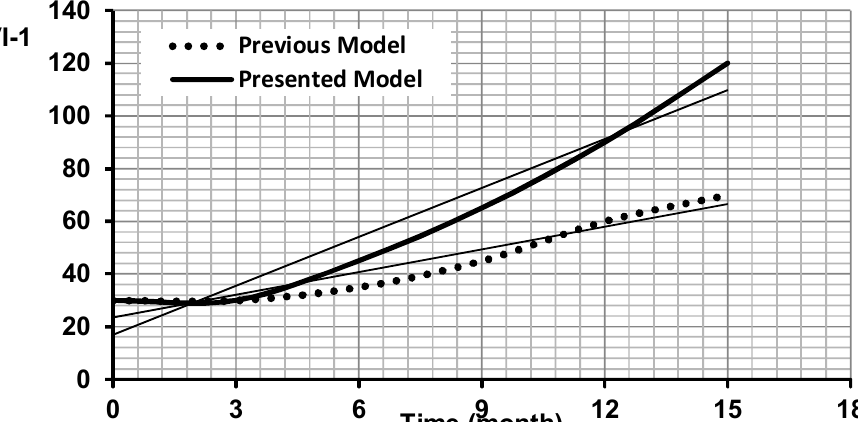
Fig. 4. Comparison between presented and previous KM implementation model for part one of the